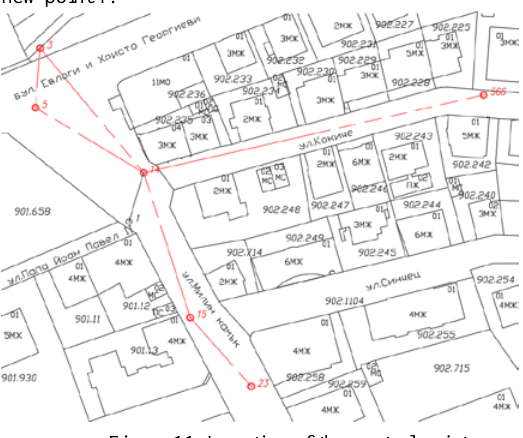
Figure 11: Location of the control points Detailed points of the boundaries of the parcels and buildings were measured and architectural elements on the facades such as windows, doors, columns, etc., which are necessary for creation of 3D model. The accessible parts of the contours of the buildings are measured by a prism. Non-reflective measurement was used in the inaccessible parts of the facades of the building. During the measurements, control distances were measured on buildings such as window width, plinth height, and more. At Figure 12 are shown part of them.